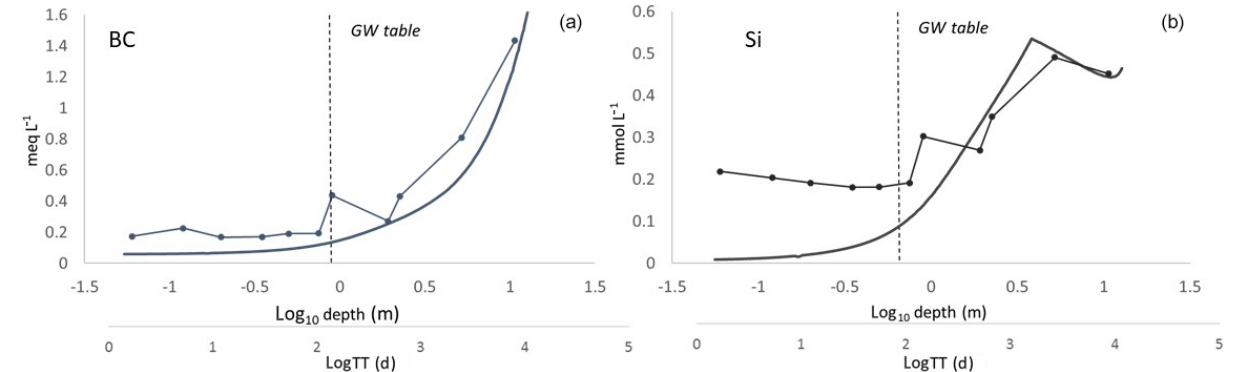
Figure 6. Modeled BC (a) and Si (b) concentrations from model 2, plotted against the log 10 of WTT (smooth lines). The observed BC and Si concentrations from the soil profile are overlain and plotted against the log 10 of soil depth (straight lines with markers). Note that the scales are not directly comparable, instead the figures are intended to illustrate trends and ranges of solute